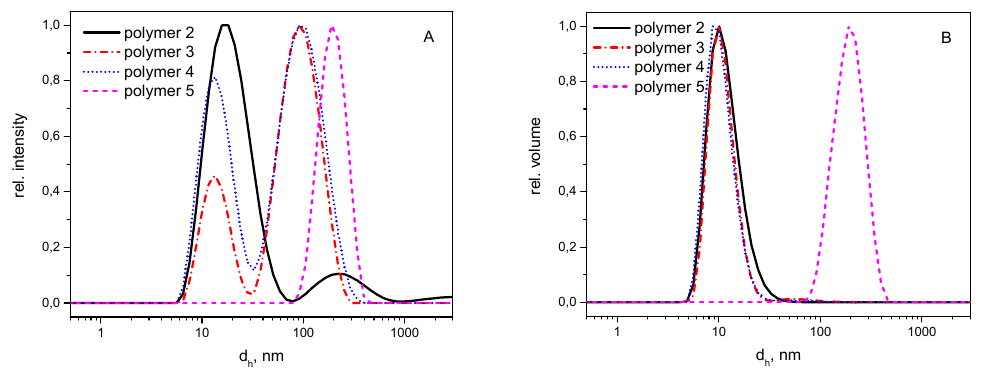
Figure 3. Molecular size distribution by intensity ( A ) and volume ( B ) as detected by dynamic light scattering for polymers 2 – 5 in phosphate buffer at pH 7.4 (polymer concentration 1 mg/mL, d h —hydrodynamic diameter).